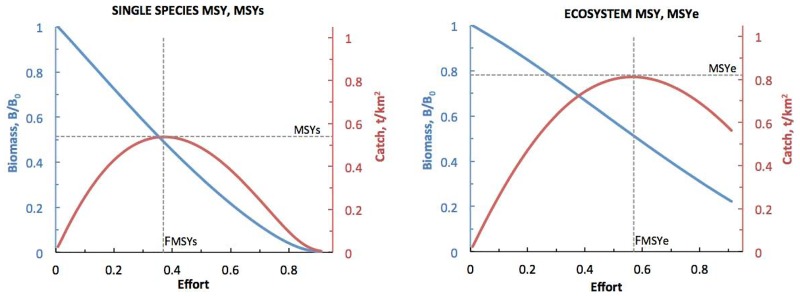
The two MSY estimates for adult herring derived from the EwE model.Single-species MSYs and ecosystem-based MSYe alike were obtained from the EwE MSY estimation tool.